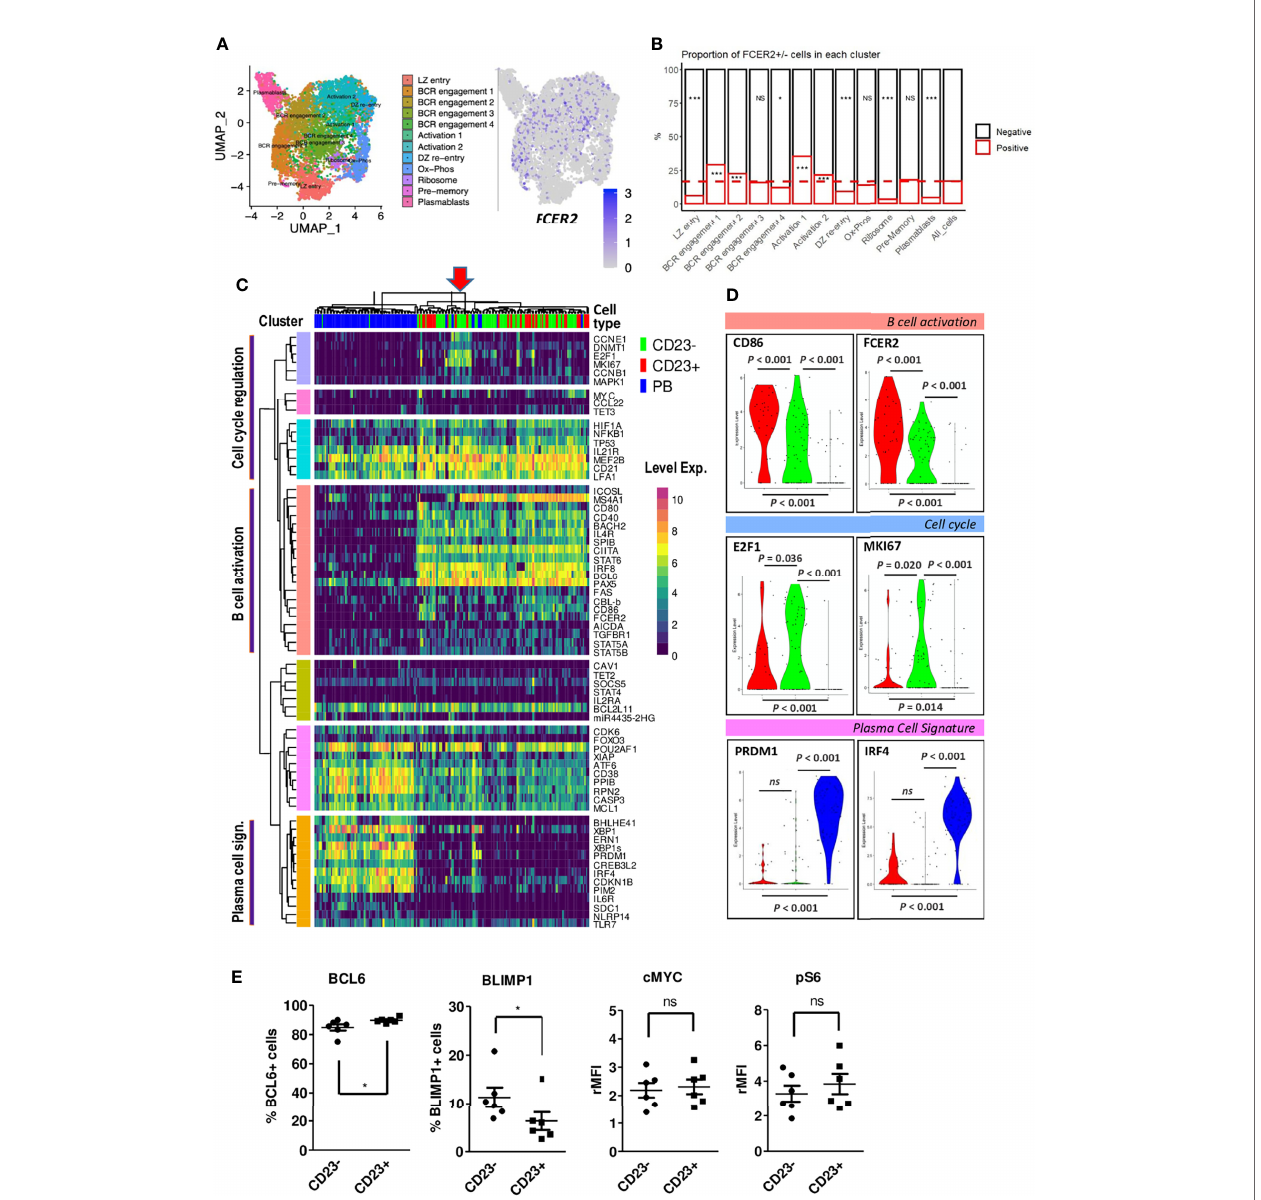
FIGURE 2 | FCER2/ CD23 expression delineates speci fi c LZ B GC -cell subsets. (A, B) Single-cell RNA-seq data for human tonsil-derived CXCR4 lo CD83 hi LZ B GC - cells in the G0-G1 phase of the cell cycle, from Holmes et al., 2020. (A) UMAP of the 12 speci fi c clusters de fi ned by Holmes et al. and expression of FCER2 in these clusters. (B) Distribution of FCER2 + (red) and FCER2 - (black) non-proliferating LZ B GC -cells, in the 12 clusters. Dotted line represent the mean value of positive cells for all clusters (last barplot named All_cells) (Chi2 test for each population vs. total cells (* P < 0.05, *** P < 0.001; signi fi cant test are indicated in the barplot of enriched CD23-negative or -positive populations accordingly). (C) Selected view of the heatmap with unsupervised clustering of single-cell RT-qPCR data comparing paired cell-sorted CD23 + and CD23 - LZ B GC -cells (CD19 + IgD - CD10 + CD38 + CXCR4 lo ) and PBs (CD19 + IgD - CD38 bright ). Annotation of three clusters of genes linked to speci fi c cell functions identi fi ed with GeneMANIA related to PCs, B cell activation and cell proliferation. The red arrow on the top of the heatmap indicate in cluster of cycling cells, mostly CD23 - LZ B GC -cells, that are positive for MYC expression represented in the Y-axis pink cluster. (D) Violin plot comparisons of the expression of few selected genes in CD23 + , CD23 - LZ B GC -cells and PBs. (E) Flow cytometry analysis of BCL6, BLIMP1, c-MYC and pS6 in tonsil CD23 + and CD23 - LZ B GC - cells. Results are expressed as the percentage of positive cells or the relative mean fl uorescence intensity (rMFI) (* P ≤ .05; "ns" for non signi fi cant; Mann-Whitney